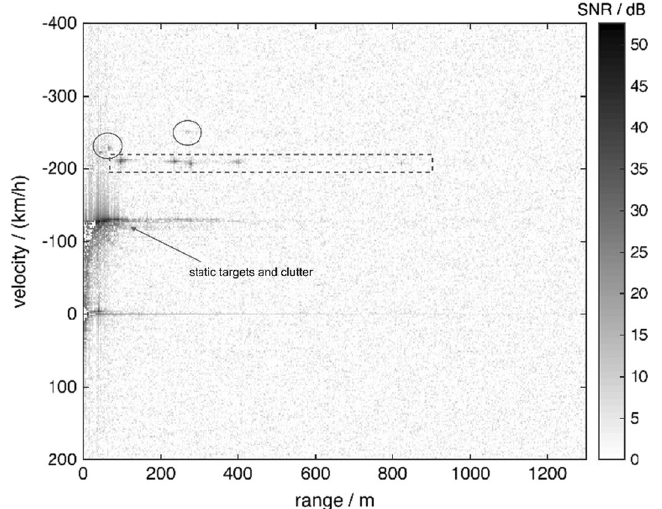
Fig. 25 Resulting range–Doppler map. All velocities are drawn relative to the proper motion of the radar platform. Due to the antenna arrangement, the static clutter appears at negative relative velocities. Two groups of road users are highlighted by either a dashed box or solid